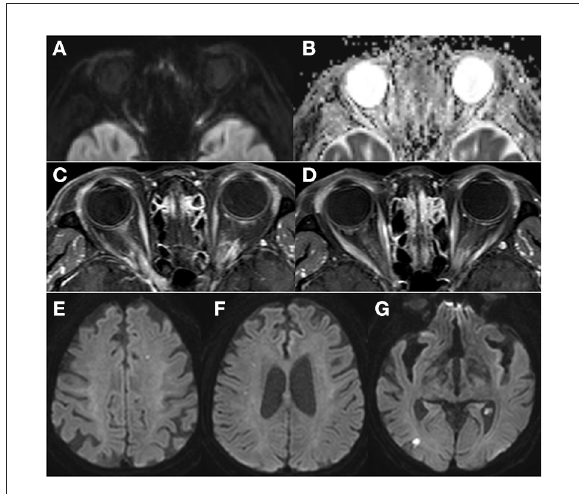
FIGURE2 Diffusion-weighted magnetic resonance imaging (MRI) of the brain revealed diffusion restriction in the posterior area of both optic nerves (A) which corresponded with the hypo-intensity in the apparent diffusion coefficient (ADC) map (B) . Contrast-enhanced axial T1-weighted images revealed enhancement of the bilateral optic nerves in the posterior segment (C,D) . Diffusion-weighted MRI of the brain showed multiple scattered lesions of high signal intensity involving bilateral periventricular white matter corresponding to acute embolic stroke (E–G)